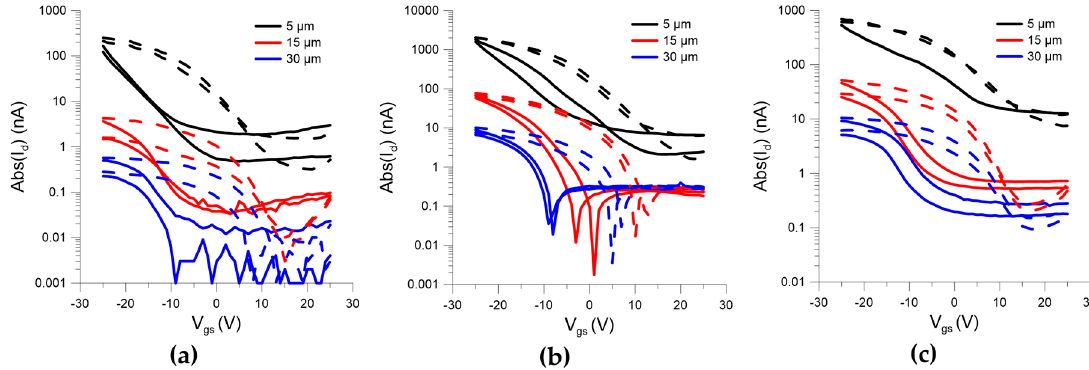
Figure 3. The I d -V gs curves for ( a ) low density; ( b ) medium density and ( c ) high density Si nanonet FETs under and gate voltage up (solid lines) and down (dashed lines) sweeps and a drain voltage of V ds = − 4